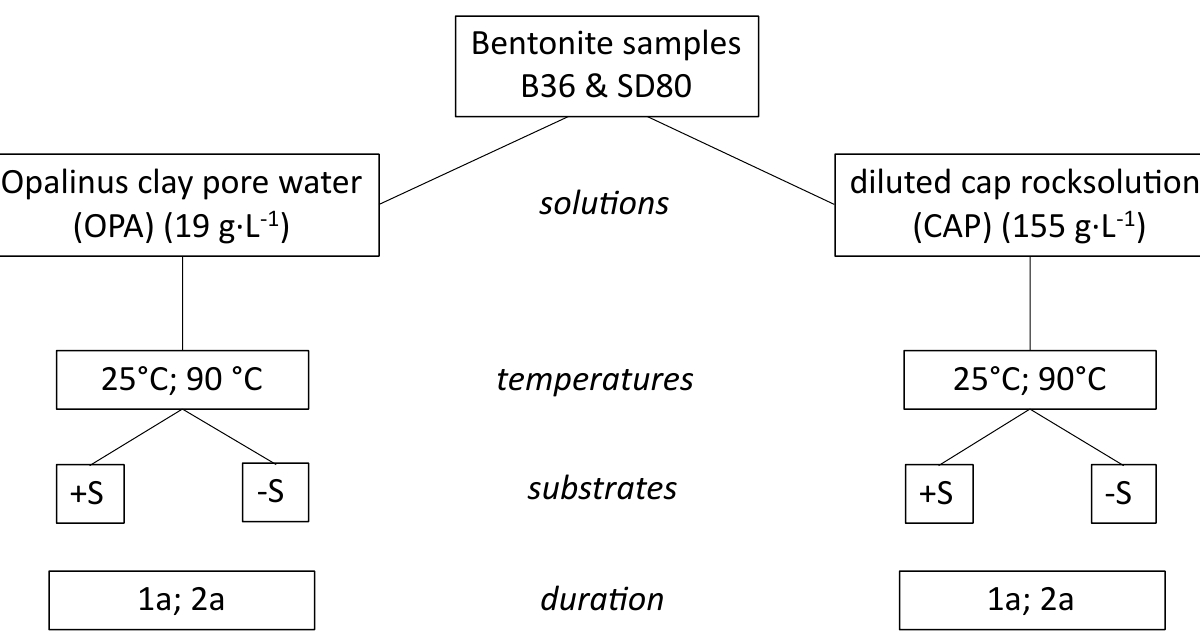
Figure 1. Flowchart illustrating the general setup of the bentonite batch-experiments. OPA: synthetic Opalinus clay pore water, CAP: synthetic diluted cap rock solution, +S: with substrate (Na-lactate, Na-acetate, methanol, AQDS), − S: without substrate, 1a: incubation for one year, 2a: incubation for two